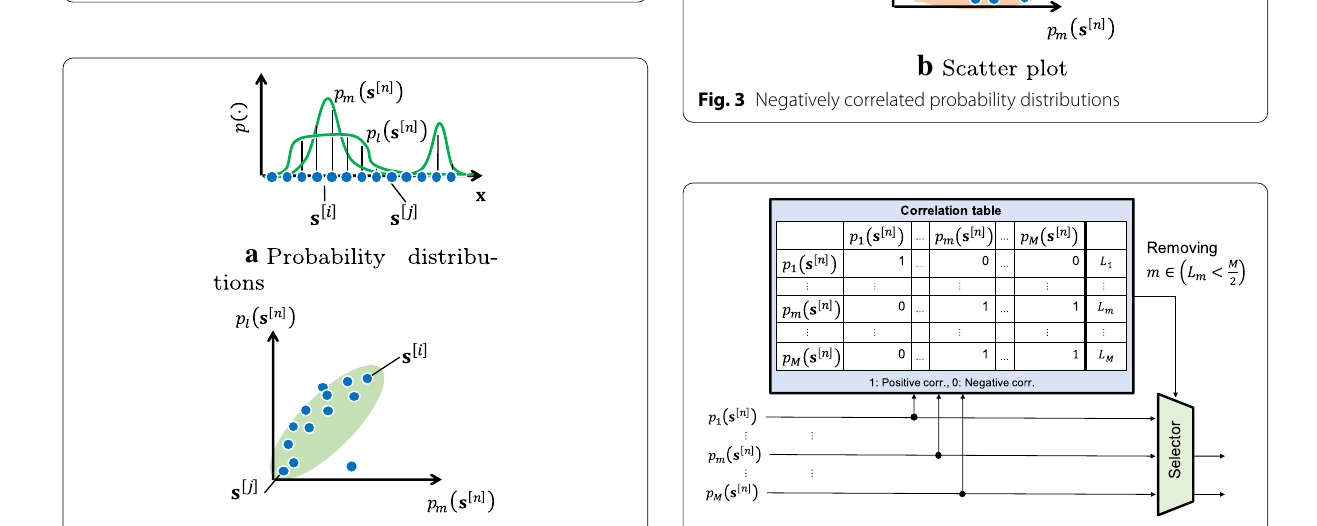
Fig. 1 Proposed sensor fusion framework